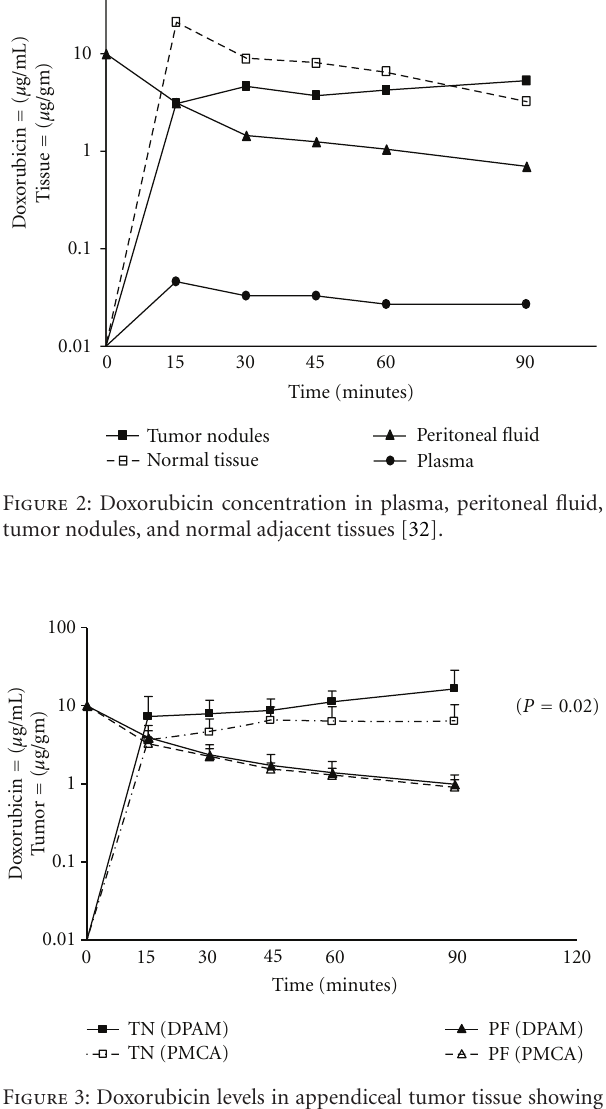
Figure 3: Doxorubicin levels in appendiceal tumor tissue showing di ff use peritoneal adenomucinosis (DPAM) versus peritoneal muci- nous carcinomatosis (PMCA). Peritoneal fluid concentrations are also shown. TN: tumor nodule; PF: peritoneal fluid